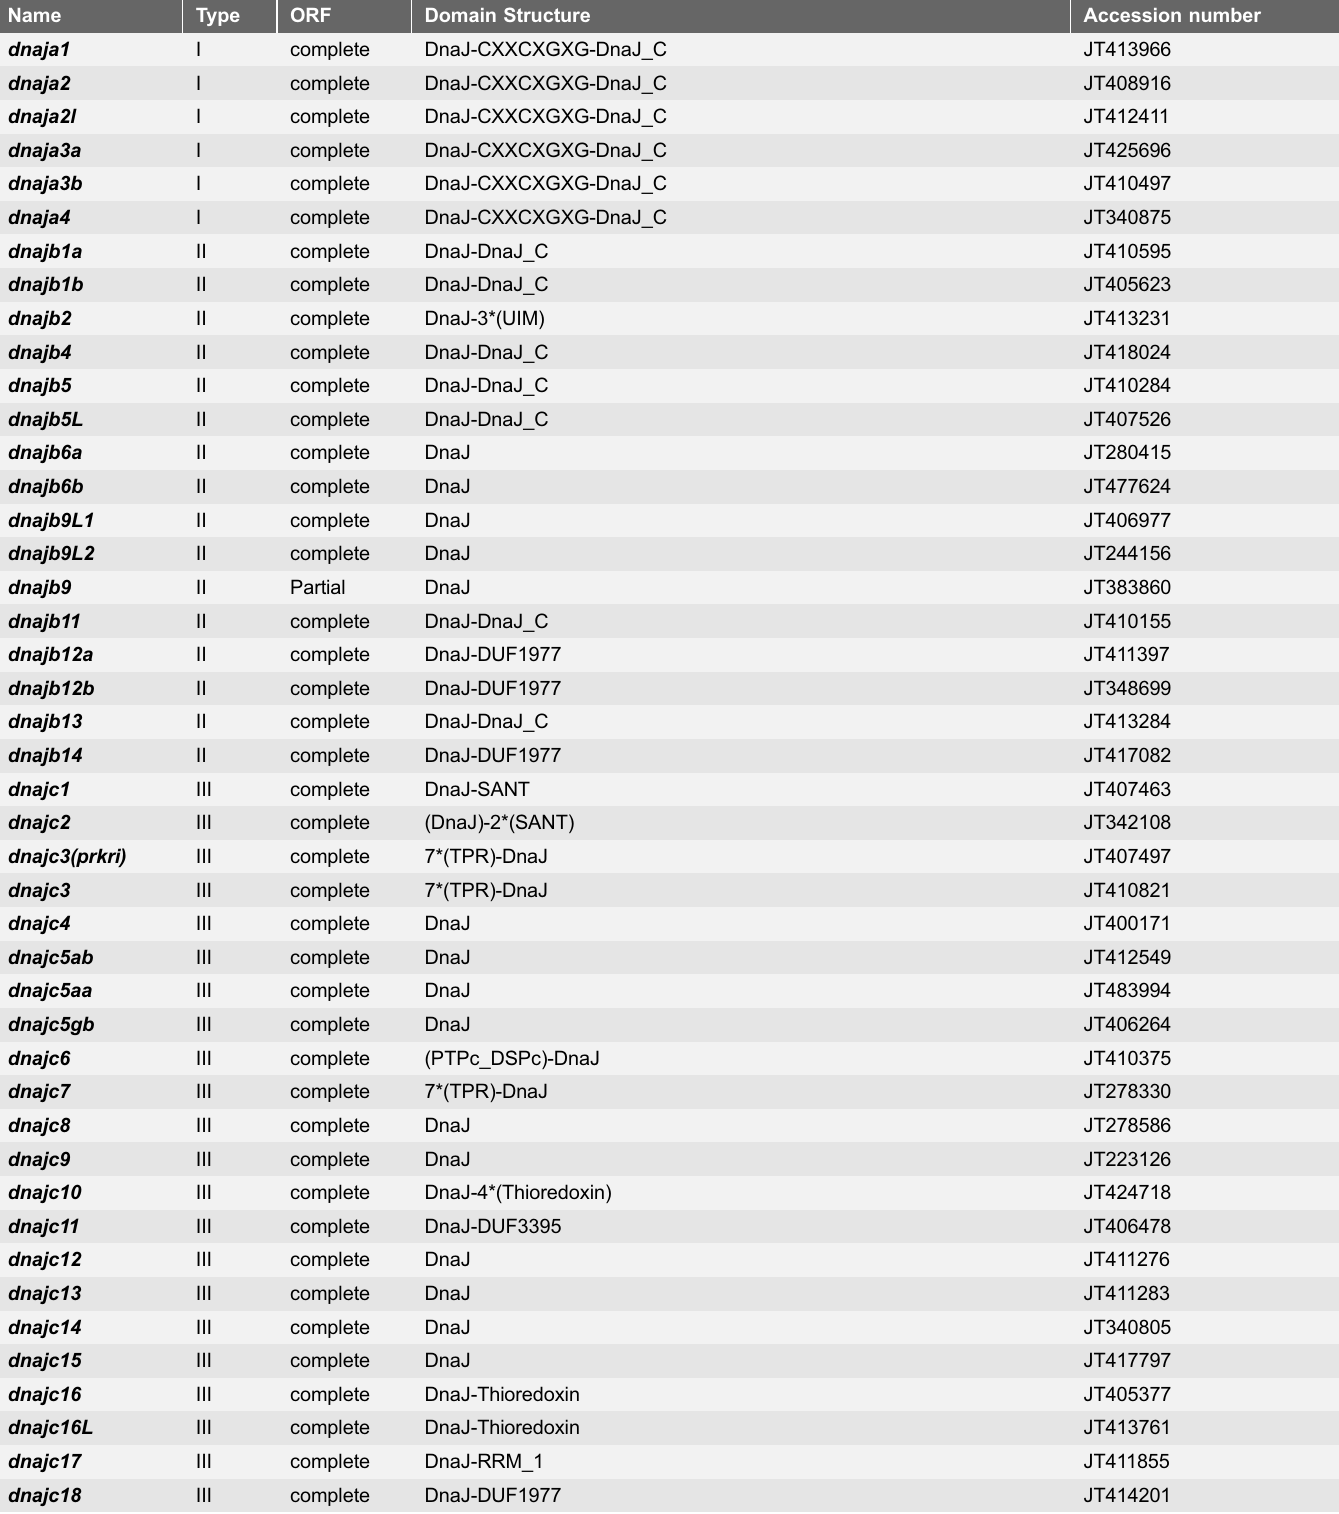
Table 1. Summary of 57 Hsp40 genes identified in the catfish